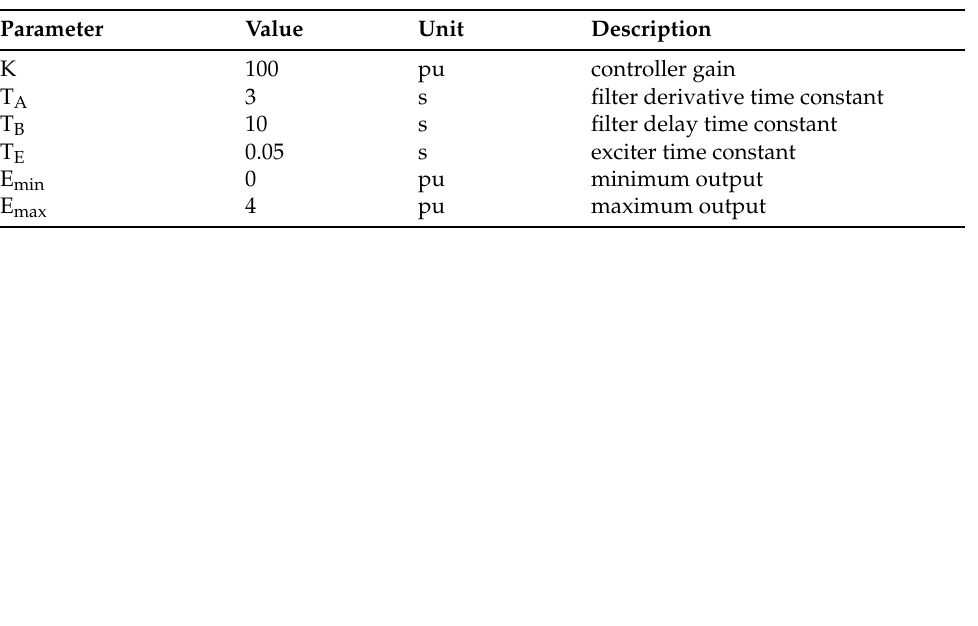
Table A1. Parameters set for the AVR